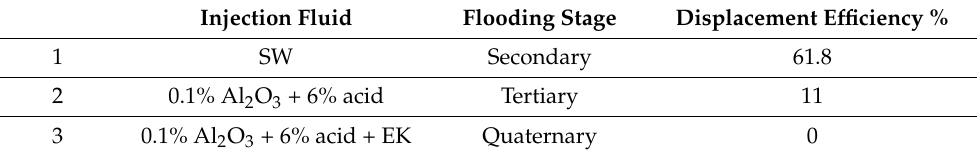
Table 10. Summary of